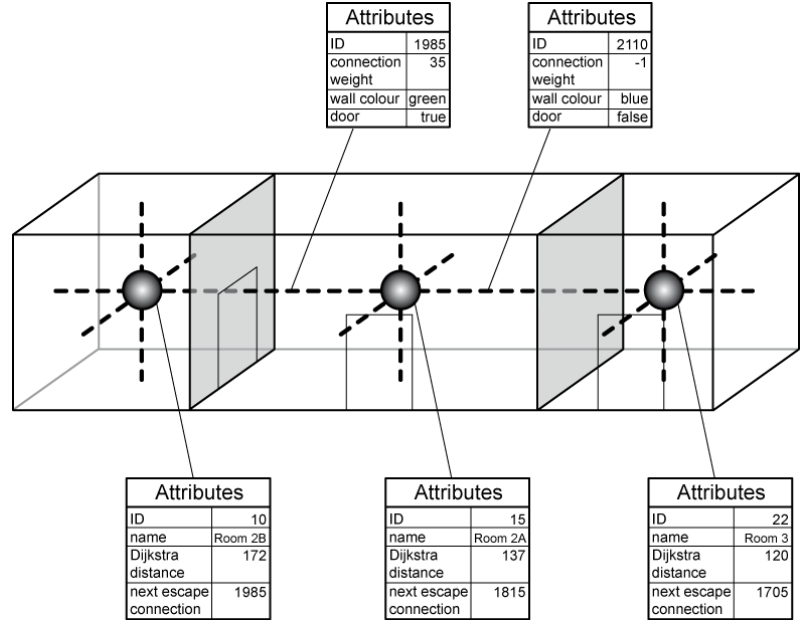
Figure 5. Attributes can be assigned to primal nodes and edges as well as to dual elements.